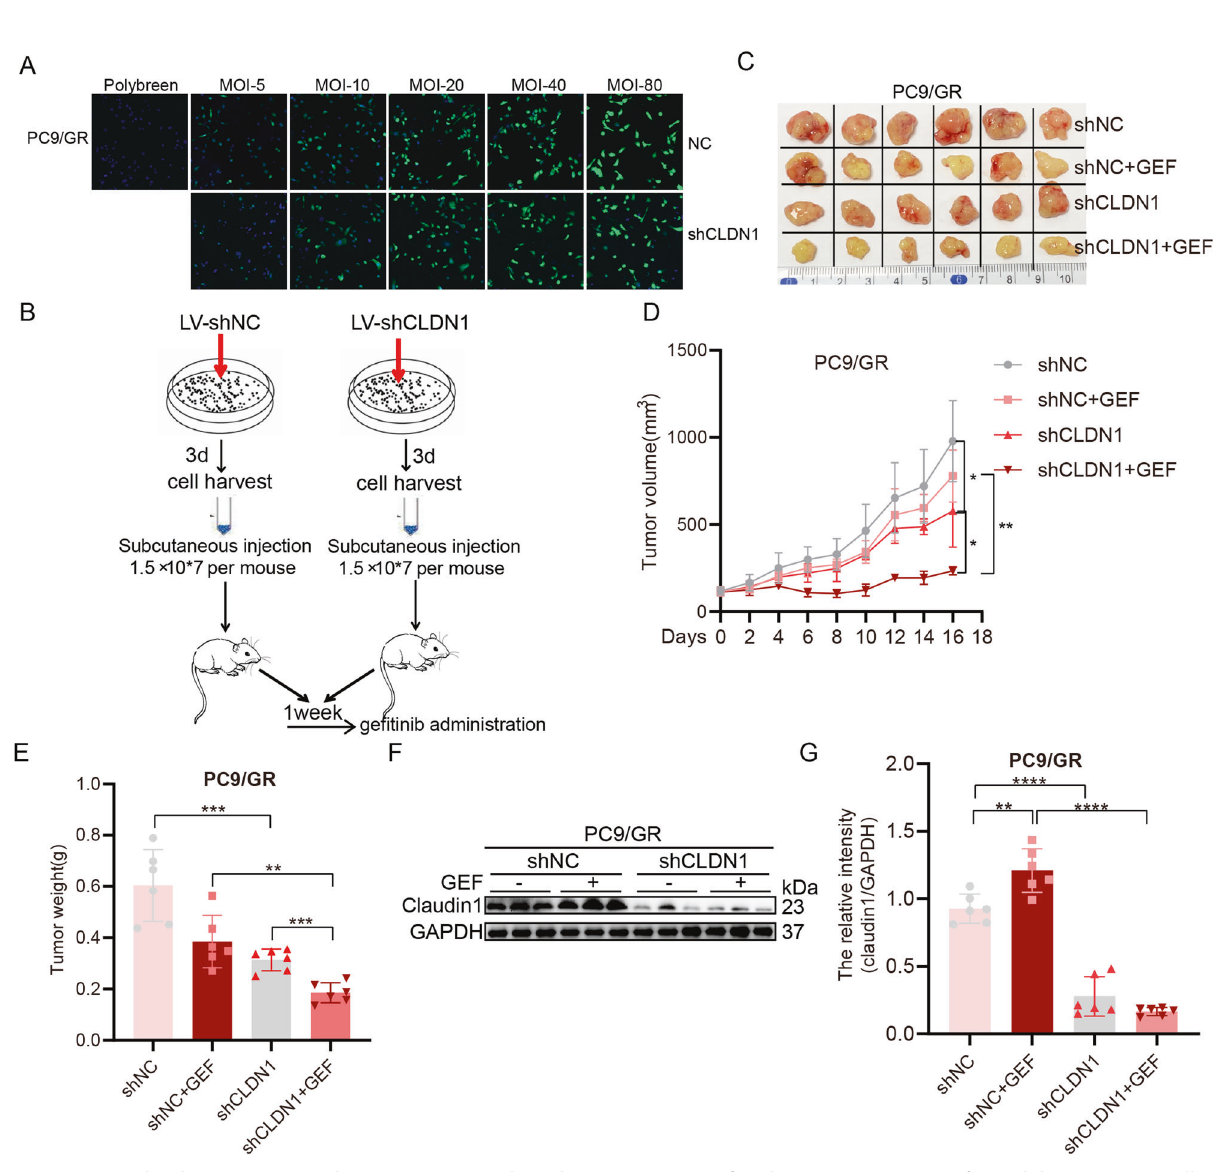
Fig. 3 Targeting claudin1 suppresses lung cancer growth and resistance to ge fi tinib in mouse xenograft models. A PC9/GR cells were infected with a lentivirus for 72 h and infection ef fi ciency was detected by a laser scanning confocal microscope. Note: Numbers represent MOI values; lentivirus concentrations: 3.0 × 10 8 TU/mL. B Flow charts for the establishment of xenograft mice models. C Macroscopic appearance of xenografts in each group. D , E Tumor sizes and weight of PC9/GR xenograft models were presented as mean ± SD; n = 6; * P < 0.05, ** P < 0.01, *** P < 0.001. F Whole protein cell lysates were randomly prepared from three tumors per group for western blotting to detect the indicated proteins. G Relative intensity of claudin1 protein was evaluated by the ChemiScope analysis software (mean ± SD; ** P < 0.01, **** P <